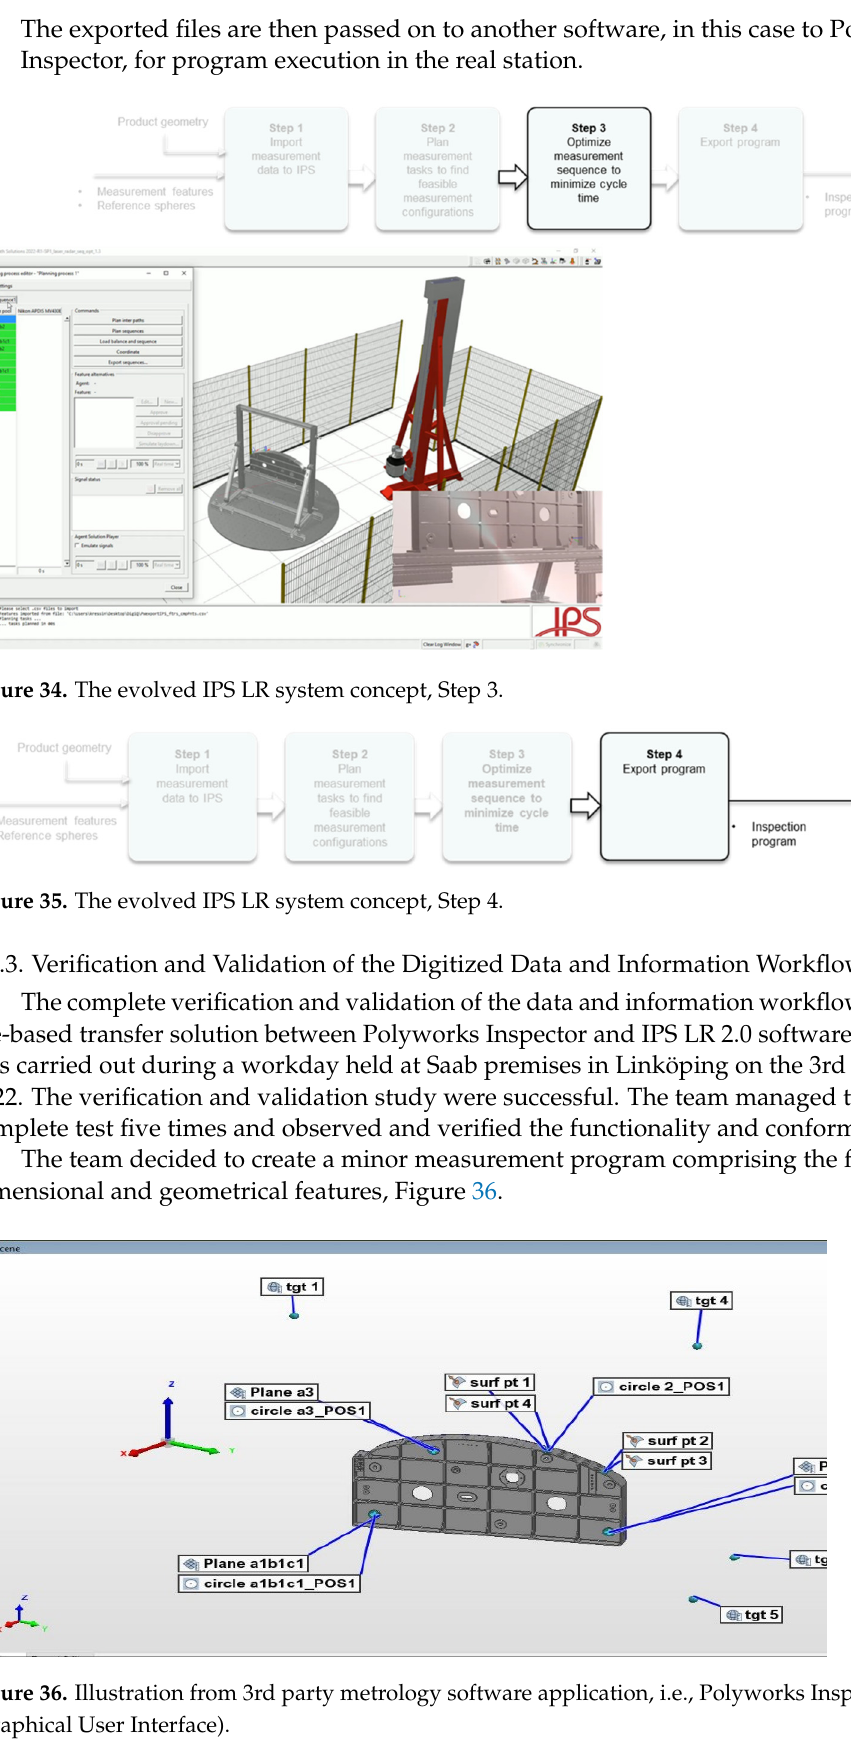
27 Figure 33. The evolved IPS LR system concept, Step 2. Step 3 In step 3 of the process, Figure 34, automatic sequence optimization is performed, i.e., the following: •